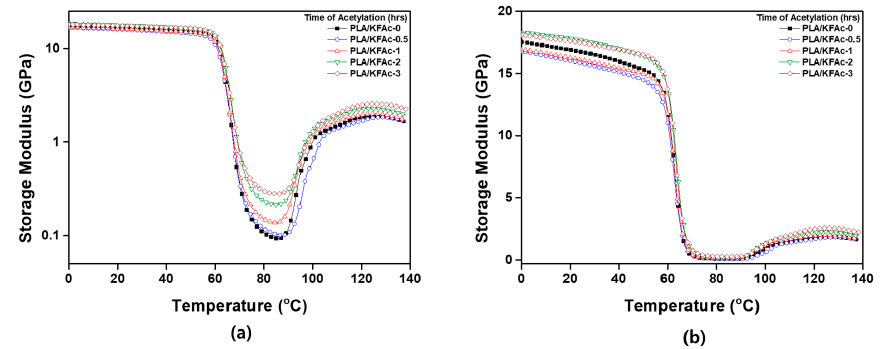
Figure 8. Storage modulus (E’) of untreated and acetylated kenaf-filled PLA composites. ( a ) Log scale; ( b ) Linear scale.